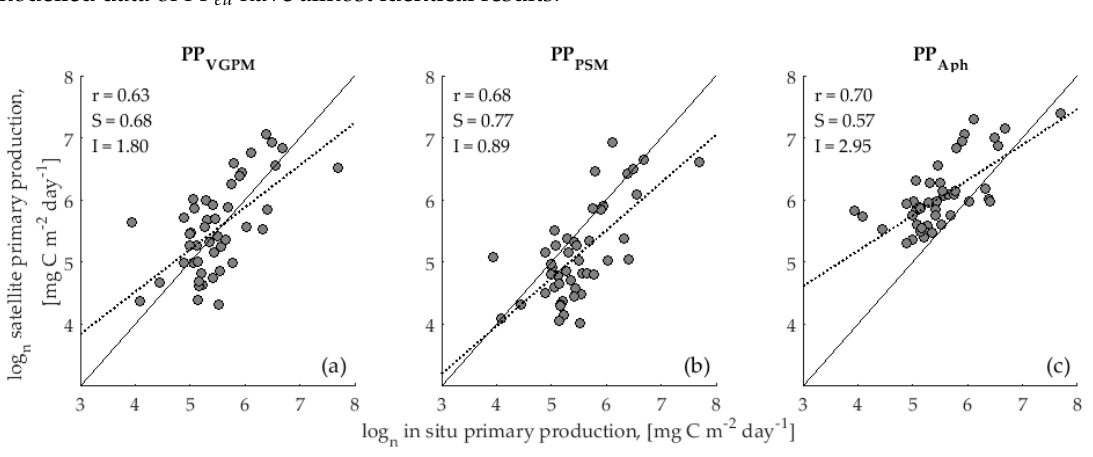
Figure 3. Scatter plots of log satellite and in situ PP eu [mg C m − 2 day − 1 ] in the NEA using daily OC-CCI data ( N = 46) for ( a ) PP VGPM , ( b ) PP PSM , and ( c ) PP Aph . Solid line is the 1:1 line; dotted line is the linear